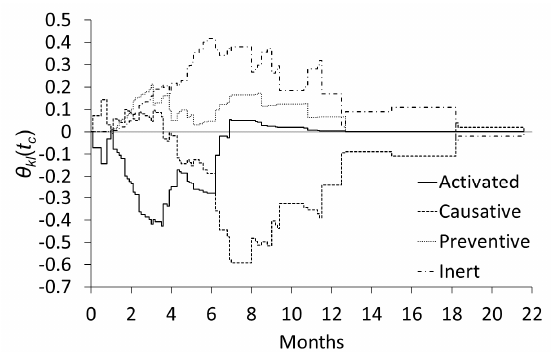
Figure 3. Di ff erences in the proportions of type kl subjects between the pancreatic head and Figure 3. Differences in the proportions of type 𝑘𝑙 subjects between the pancreatic head and “other” “other” subgroups. subgroups.